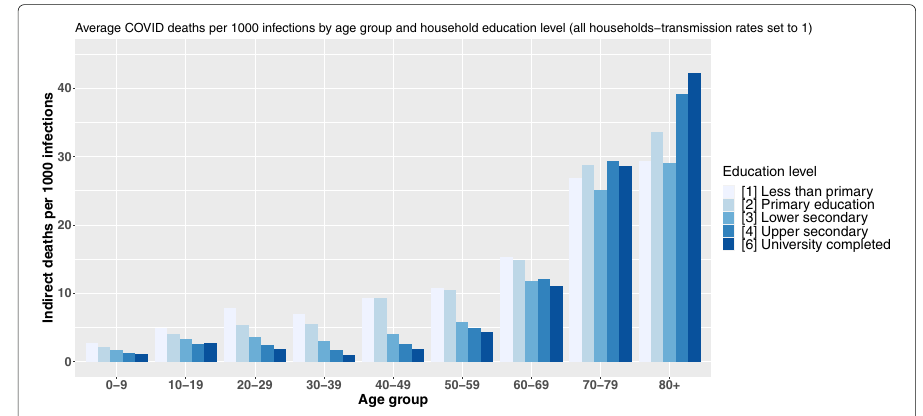
Fig. 12 Average COVID-19 deaths per 1000 infections by age group and head-of-household education level (rates of transmission set to 1)